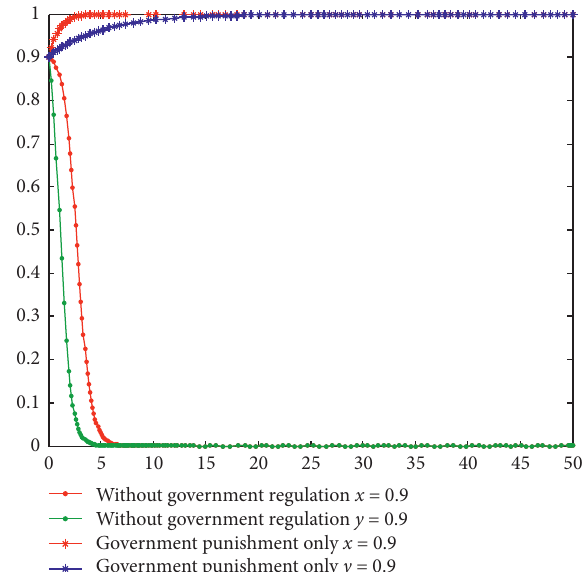
Figure 4: Influence of government punishment on the formation of the green dairy industry